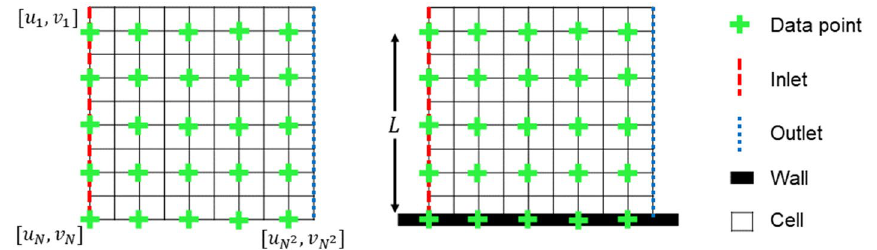
Figure 2. Schematic of the N × N sample grids used for the local Navier-Stokes approximation. There are two configurations for the grids: in the freestream or near a wall with a boundary layer present. Velocity data from the inlet of the grids were used as an input to the KBaNN, which estimated the velocities for the entire sample grid .